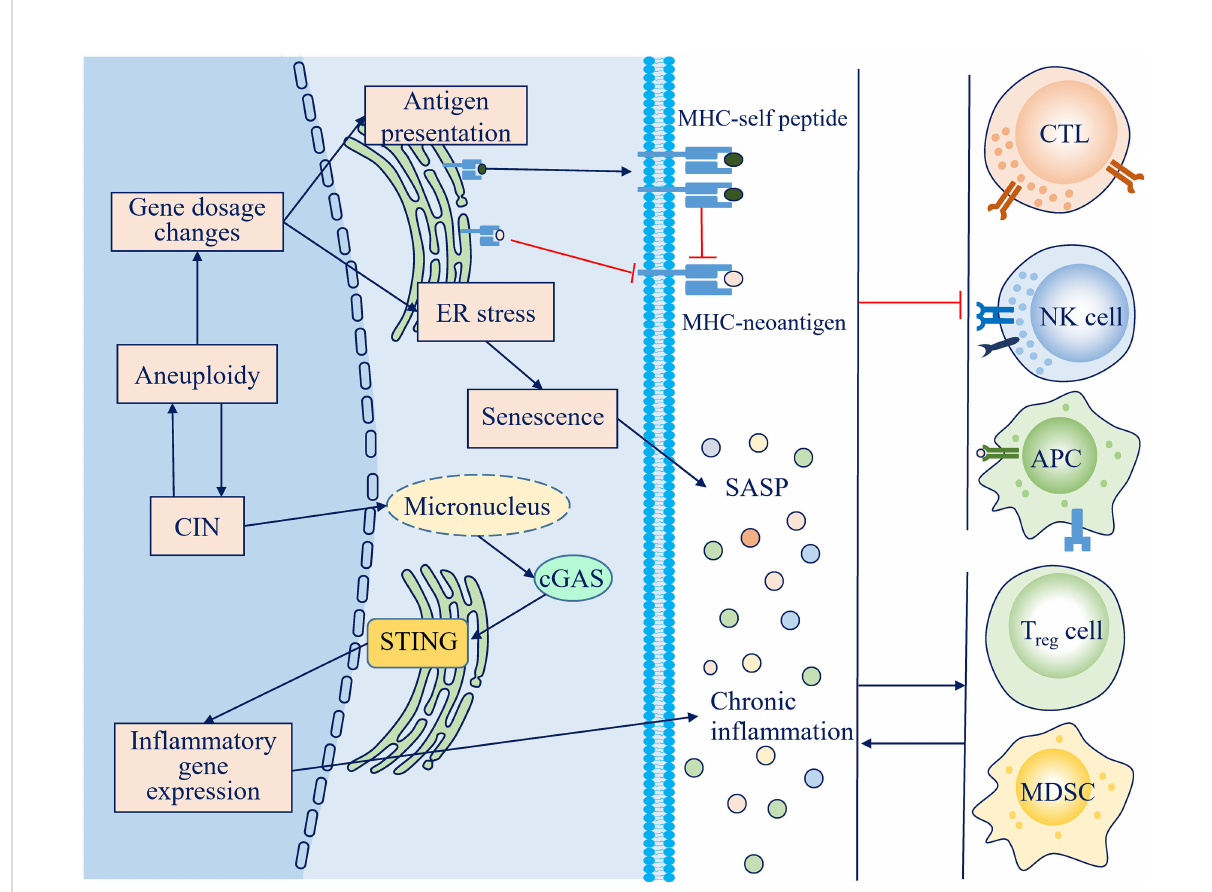
FIGURE 2 Mechanisms through which chromosome instability (CIN) and aneuploidy escape the antitumor immune response. Persistent activation of the cGAS-STING pathway and the senescence-associated secretory phenotype (SASP) lead to a chronic in fl ammatory microenvironment, which impairs the antitumor immune response and facilitates an immunosuppressive microenvironment. Loss of neoantigens and antigen presentation machinery during CIN, along with competitive inhibition by self-peptides attributed to protein imbalance, decreases the immunogenicity of CIN/ aneuploid